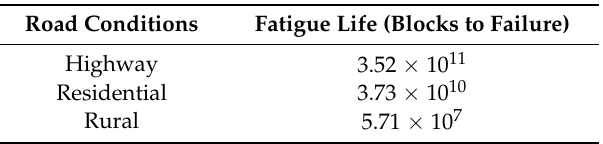
Table 12. Strain predicted fatigue life using Coffin-Manson